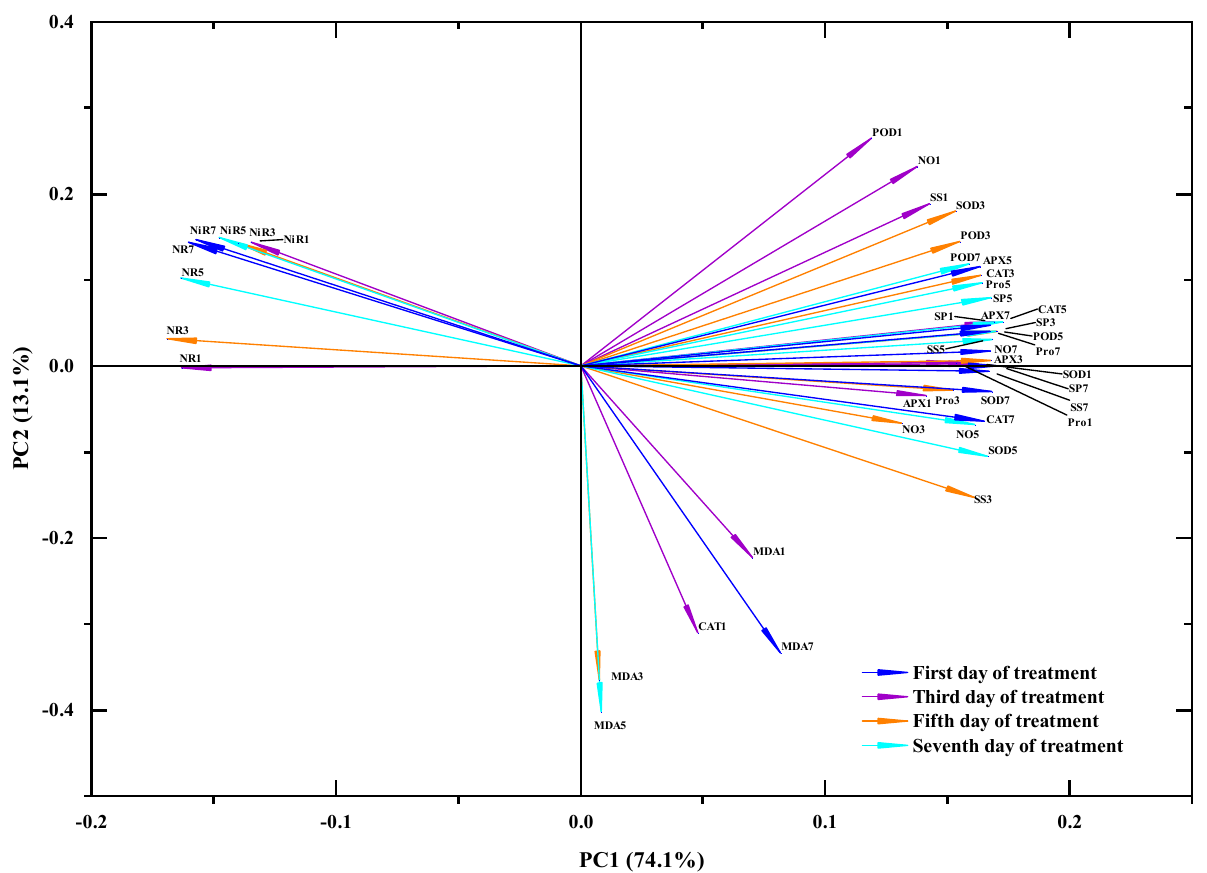
Figure 6. Principal Component Analysis. The projection of the line represented by a certain variable on PC1 and PC2 is the contribution of the variable to the sample separation. The longer the line, the larger the projection and the more significant the impact. The blue line represents the treatment on the first day, the purple line represents the treatment on the third day, the orange line represents the treatment on the fifth day, and the cyan line represents the treatment on the seventh day.